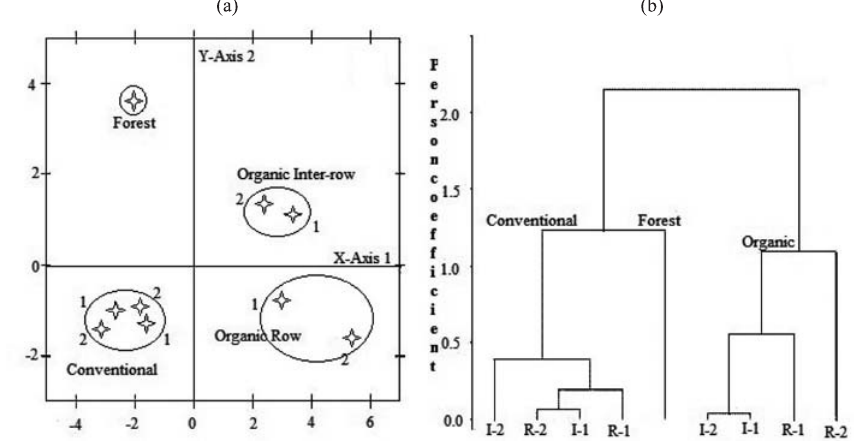
Figure 1. (a) Discriminant analysis by PCA. (b) Cluster analysis. R: Row, I: Inter-row; 1: Isabel cultivar, 2: Bordô